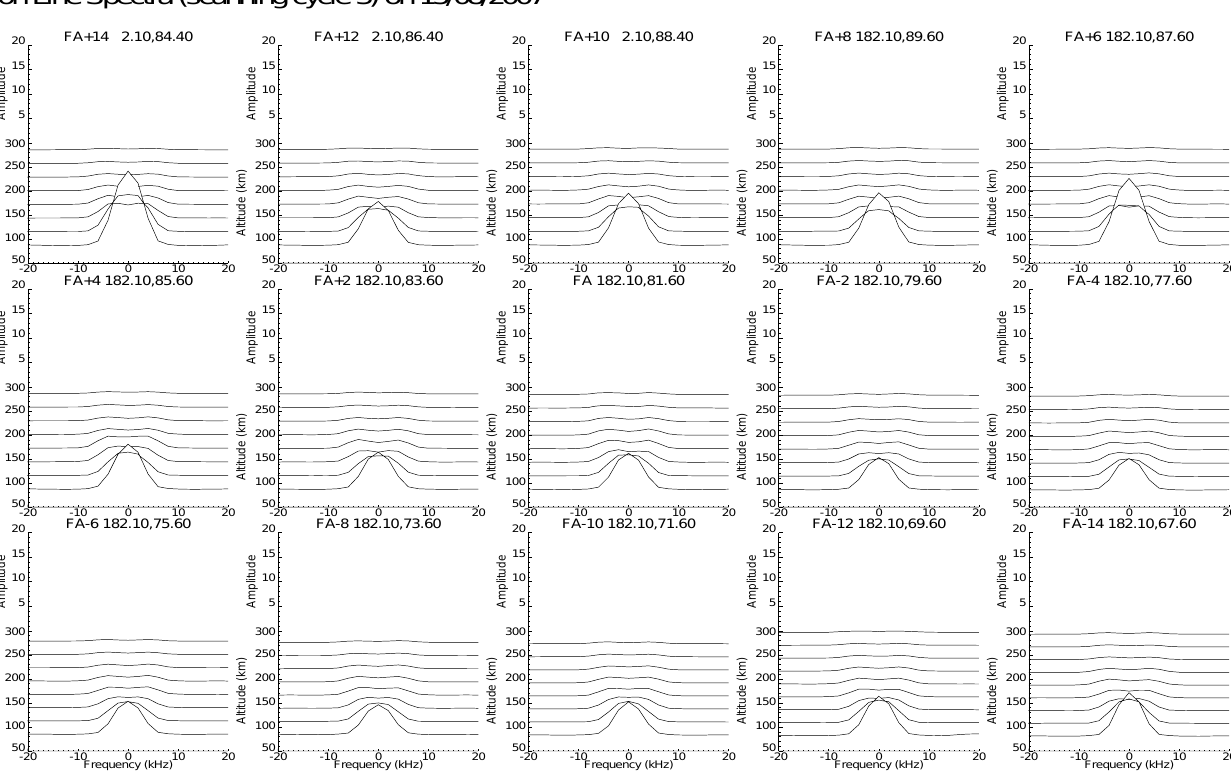
Fig. 10. Ion line spectra from scanning cycle 3 from interval 3. Since the cycles shown here comprise fifteen pointing directions instead of seven, the panel layout has been amended appropriately. Therefore fifteen panels have been used, one for each of the pointing directions from FA+14 to FA − 14 (left to right and downwards), with the axes in each data panel again showing the frequency, the altitude and the spectral amplitude. As before, each panel direction is labelled using its designation, e.g. FA+10, followed by the azimuth and elevation of that pointing direction. The main features in this data are the characteristic E-region amplitude increases. These occur in many directions, from FA+14 to FA − 6, with a notable prevalence of high-amplitude scatter being present around vertical. Although F-region spectral signatures are present, there is little evidence for SPEAR-induced amplitude increases in these F-region